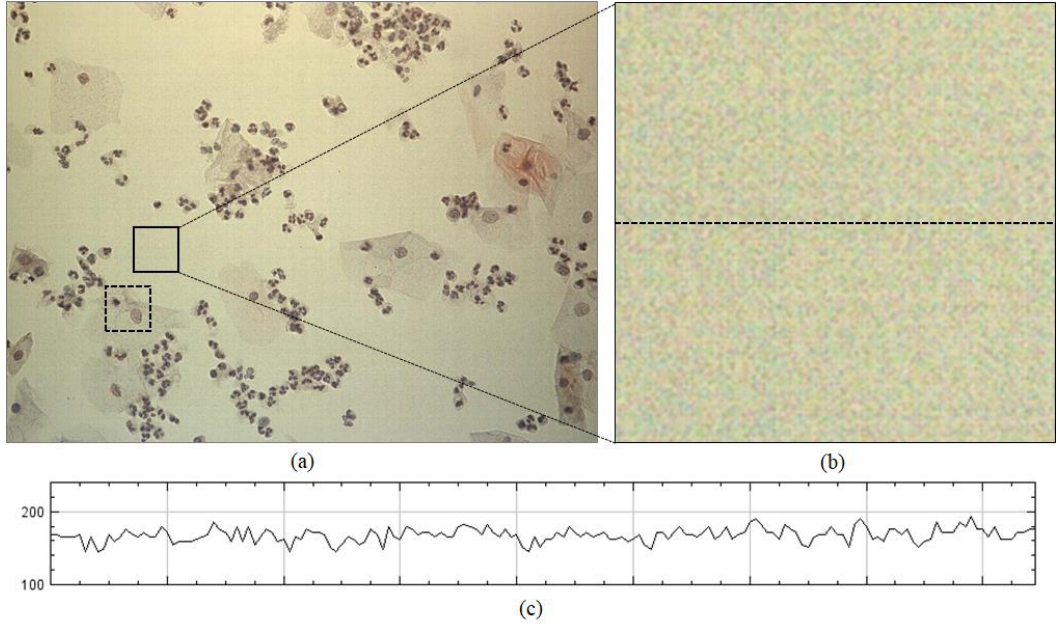
Figure 8. Example of fixed-pattern noise: ( a ) input image tile, ( b ) enlarged image and ( c ) intensity profile for the red channel on dotted line segment of ( b ).